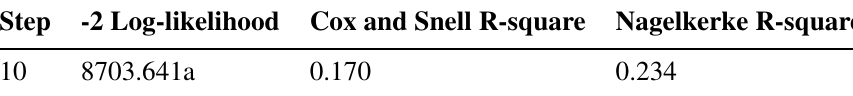
Table 3 Explained variance of the binary logistic regression model.